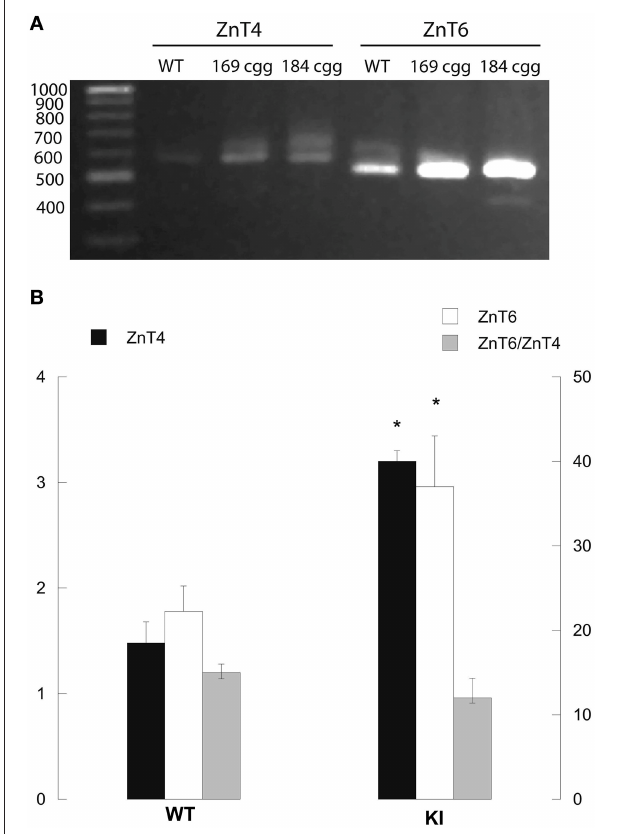
FIGURE 9 | ZnT4 and ZnT6 gene expression in mammary glands from lactating WT and KI dams. Representative image of the PCR products (obtained by RT-qPCR as described under Methods) that were separated in a 1.3% agarose gel and visualized with ethidium bromide (A) . The fragments exhibited the expected sizes of 585 bp ( ZnT4 ) and 537 bp ( ZnT6 ). GAPDH PCR product was separated in a 3% agarose gel electrophoresis with ethidium bromide resulting in a product of the expected of 107 bp (not shown). Intensities of ZnT4 and ZnT6 bands were obtained in a Kodak Imager were normalized by that of GAPDH (B) . Bars represent averages ± SEM of 4 individuals/genotype. Statistical analysis was carried out with the Student’s t -test between WT and KI. * p <